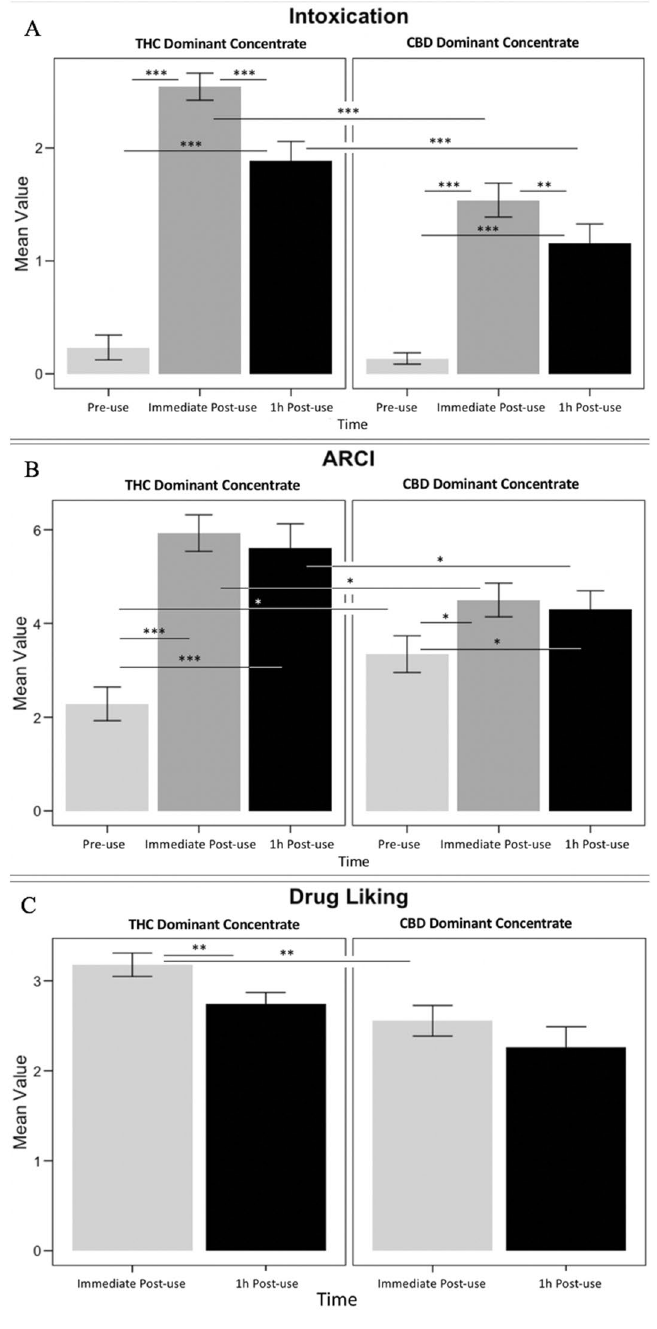
Figure 1. Subjective drug effects; within group significant differences were determined by paired t-tests and between group differences were determined by independent t-tests for the purpose of denoting differences in timepoints visually. ( A ) Composite self-report intoxication scale, ( B ) ARCI drug effect, ( C ) DEQ drug liking measure. (*) indicates significance at p < 0.05; (**) indicates significance at p < 0.01; (***) indicates significance at p <